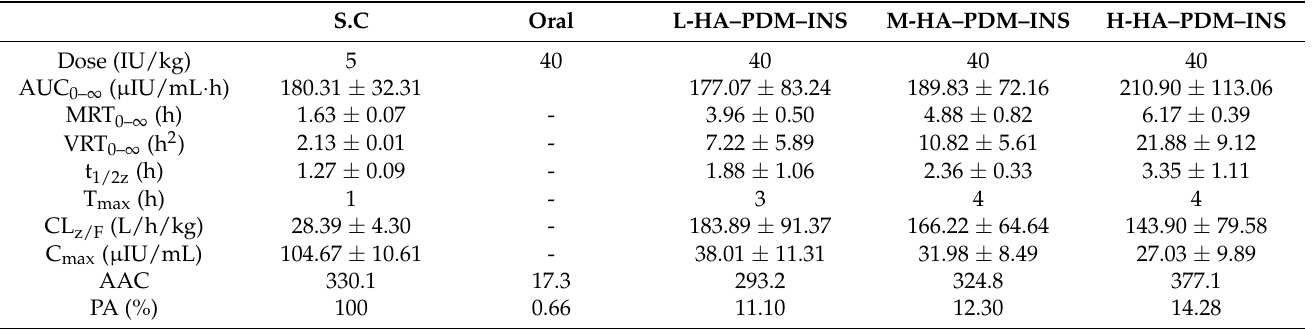
Table 5. Pharmacodynamic parameters after administrating different insulin samples in rats. (X ± SD, n = 6).